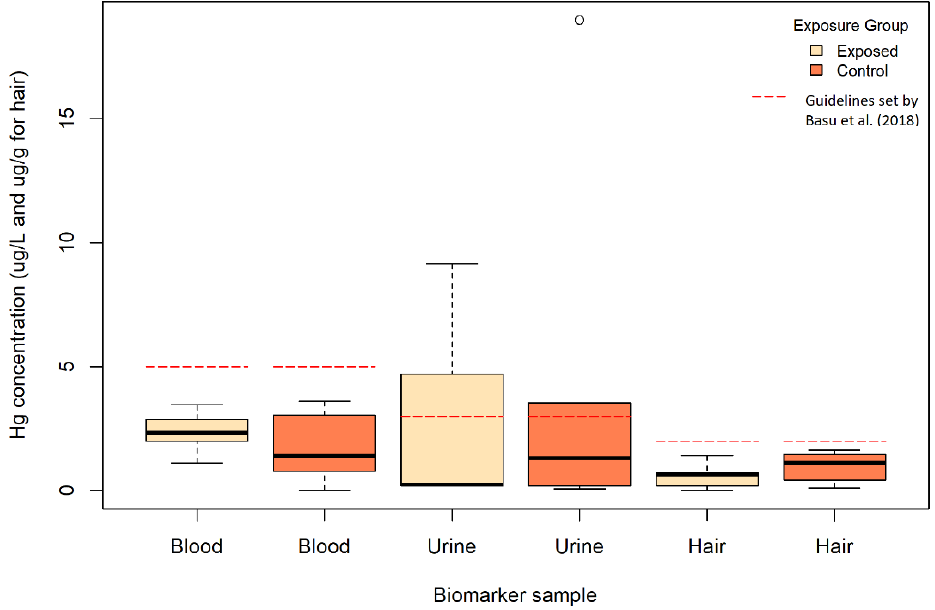
Figure 4. Central Tendency Values of Mercury in Biomarker Samples of Populations Exposed to E- Waste.